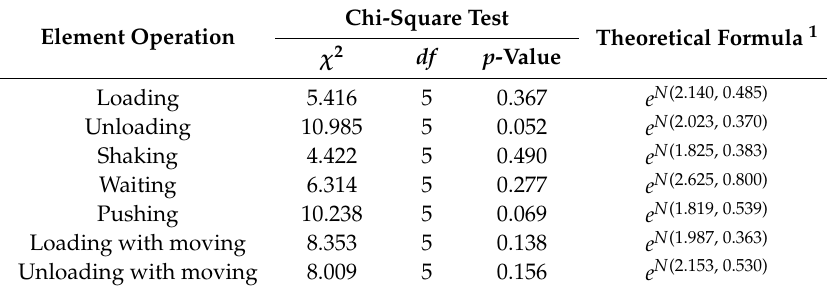
Table 3. Results of chi-square tests and theoretical formulae of element operation